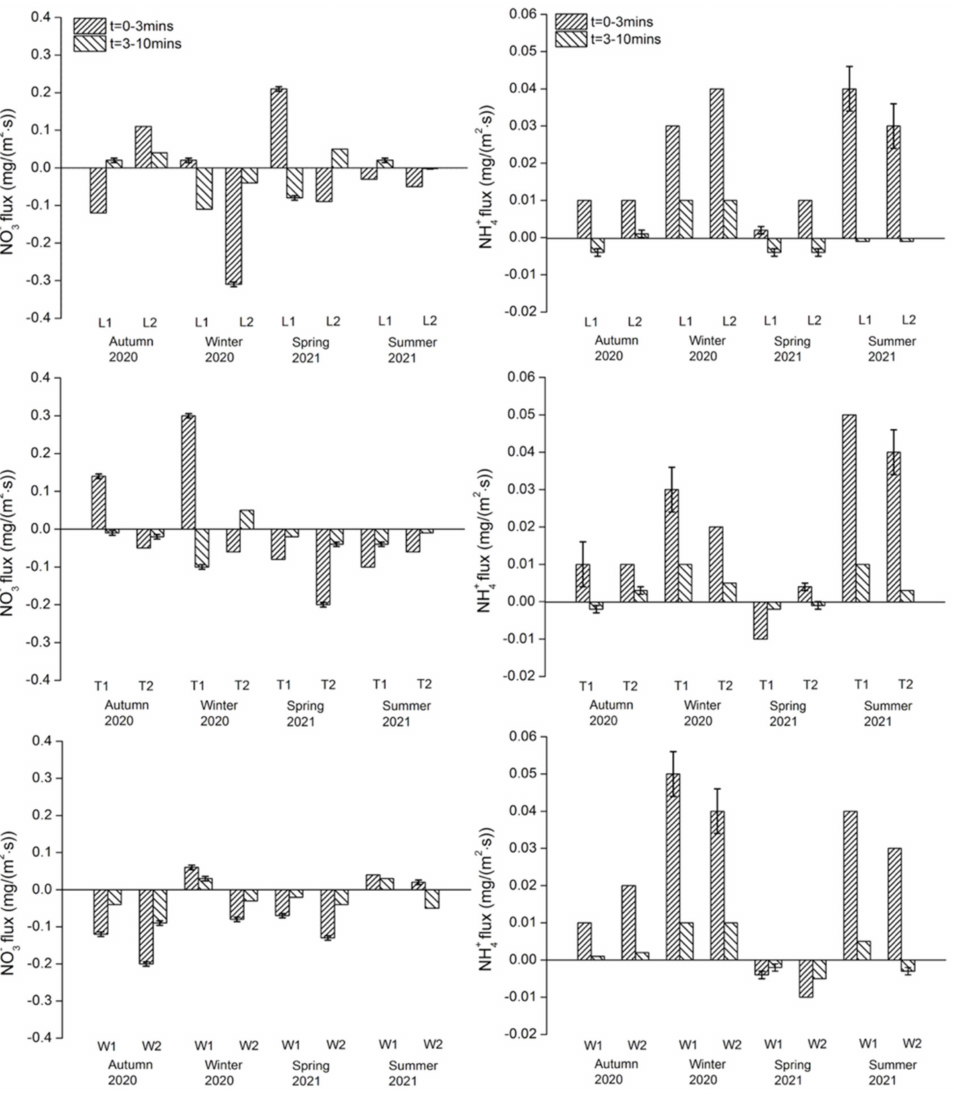
Figure 4. NO 3 − and NH 4 + fluxes of sampling events during the study period for each study river. Downwards flux represents uptake/removal of nutrients from overlying water to sediment and upwards flux represents regeneration/release of nutrients from sediment to water. The flux experiment at each site has three replicates, if the results are different, the error line is marked on the